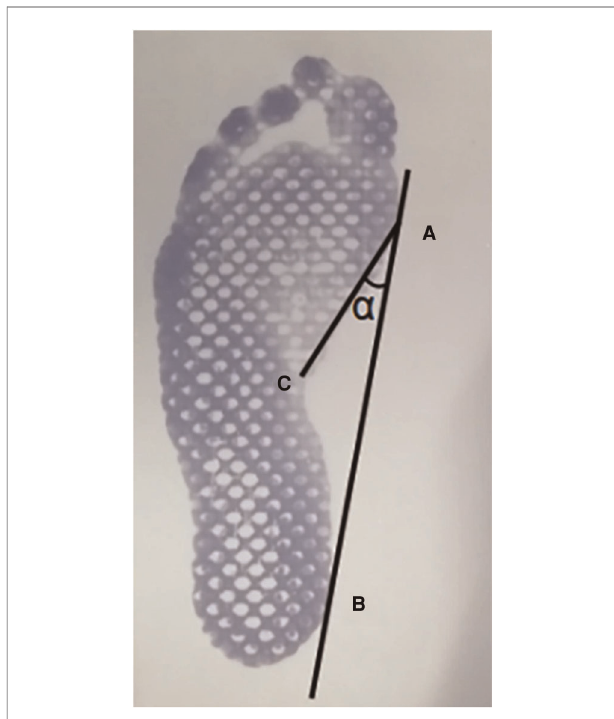
FIGURE 1 | Clarke ’ s angle measurement method using footprints. ( A ) the most medial point of the sole; ( B ) the most medial point of the heel; ( C ) the most concave point on the foot pro fi le; α : the Clarke ’ s angle.